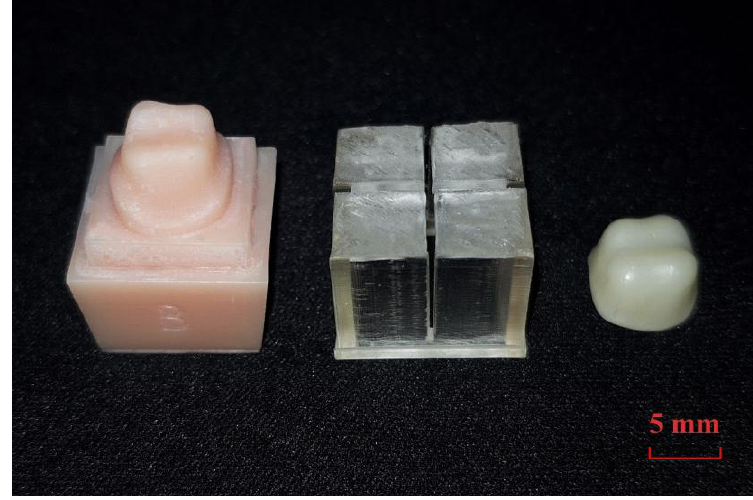
Figure 2. Study model, guide template, and zirconia coping from left to right.